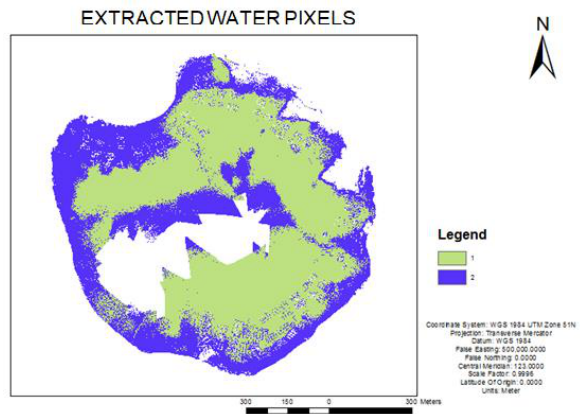
Figure 6. Extracted water pixels of NIR reflectance map